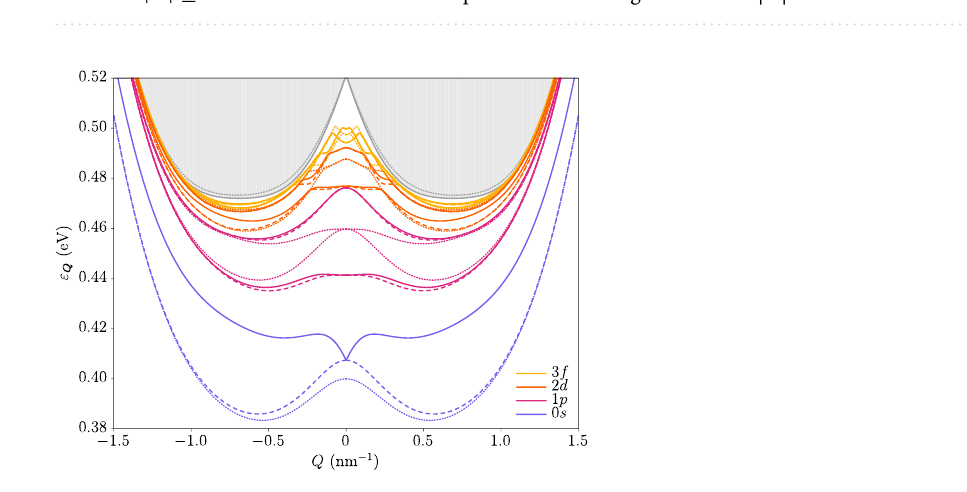
Figure 5. Excitonic dispersion relation for the Coulomb potential. All colors and line types are equivalent to their counterparts in Fig.